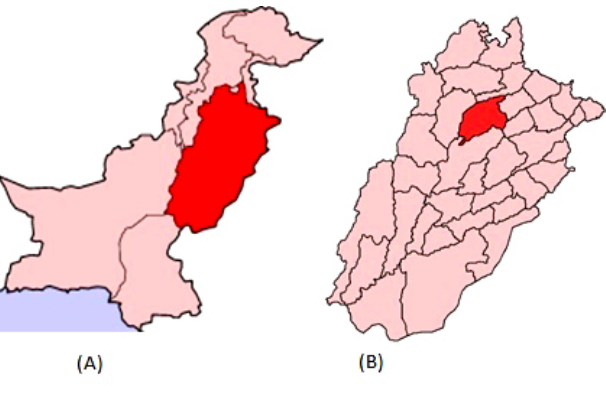
Fig. 1. Location of the study. (A) Location of Punjab in Pakistan. (B) Location of Sargodha district in Punjab. Source: Government of